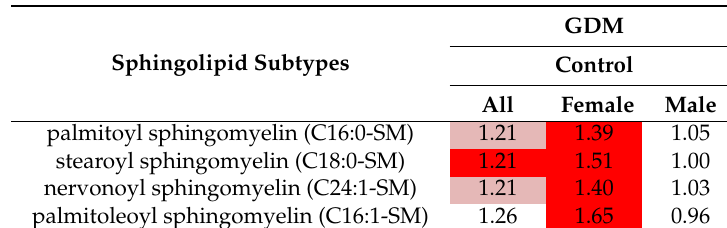
palmitoleoyl sphingomyelin (C16:1-SM) 0.96 the groups shown; metabolite ratio of ≥ 1.00. Light red: narrowly missed statistical cutoff for significance 0.05 < p < 0.10, metabolite ratio of ≥ 1.00. Non-colored cell: mean values are not significantly different for that comparison. GDM: gestational diabetes.